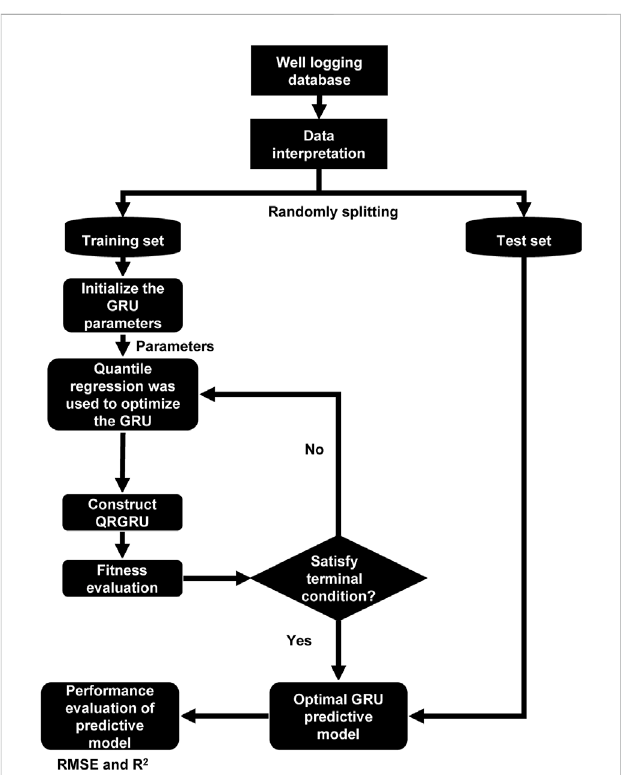
FIGURE 2 Flow of gated recurrent unit neural network based on quantile